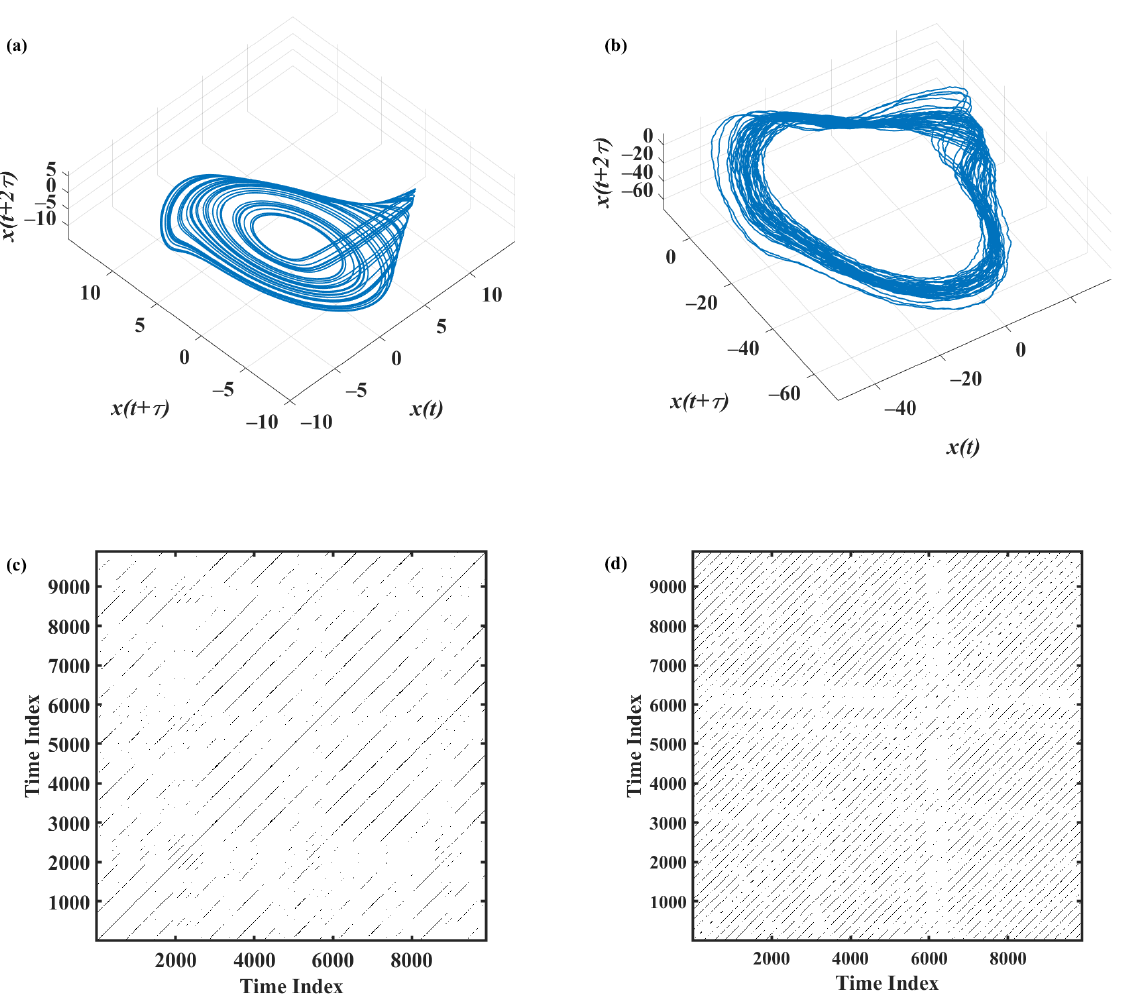
Figure 4. Reconstructed attractors from x time series of ( a ) original ( θ = 0) and ( b ) noisy ( θ = 0.25) Rössler systems and the resulting RPs (panels ( c ) and ( d ), respectively).